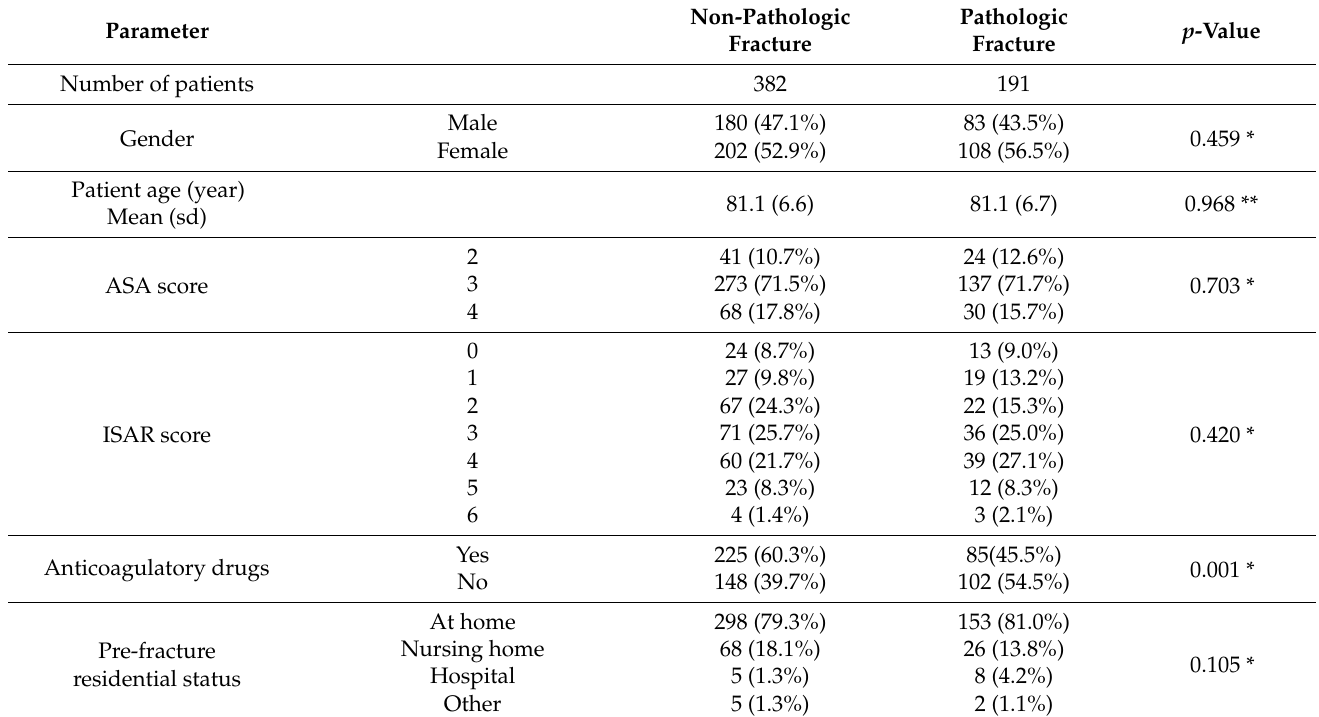
Table 2. Univariable analysis of a 2:1 optimal propensity score matching analysis of data on geriatric trauma patients with hip fractures depending on the kind of fracture